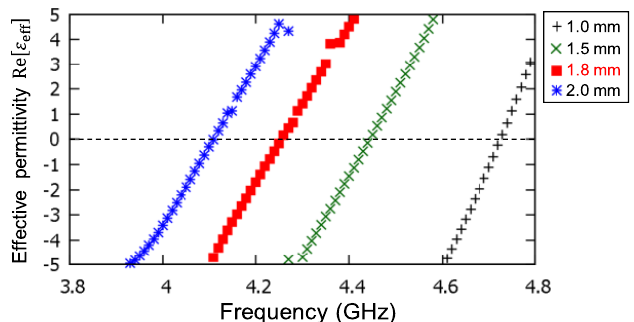
Fig. 10. Extracted real part of the effective permittivity for the structure with printed meander-line patterns.